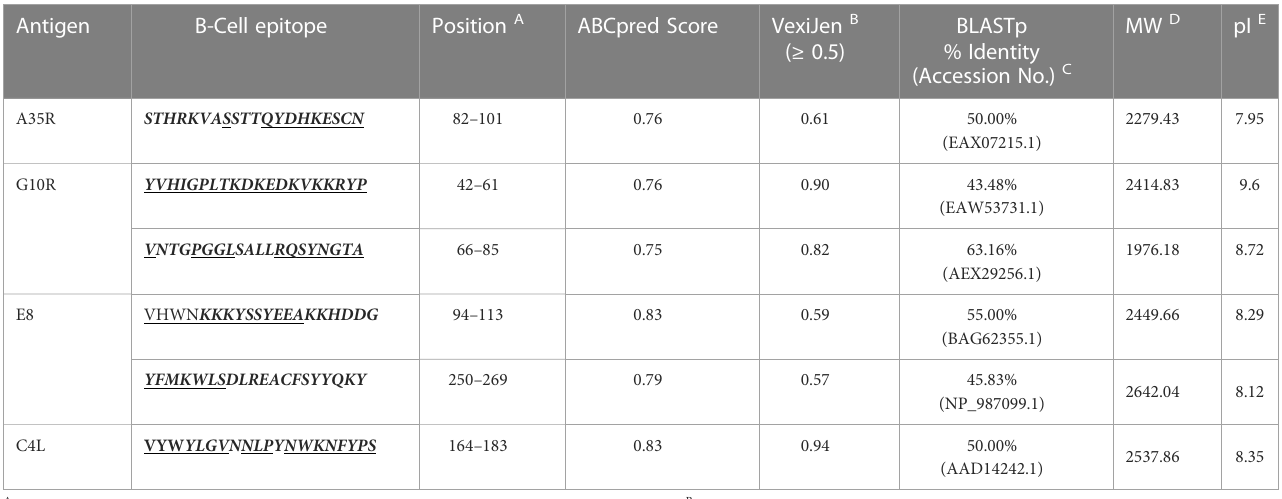
TABLE 4 The amino acid sequence of fi nal candidates B-cell epitopes for vaccine